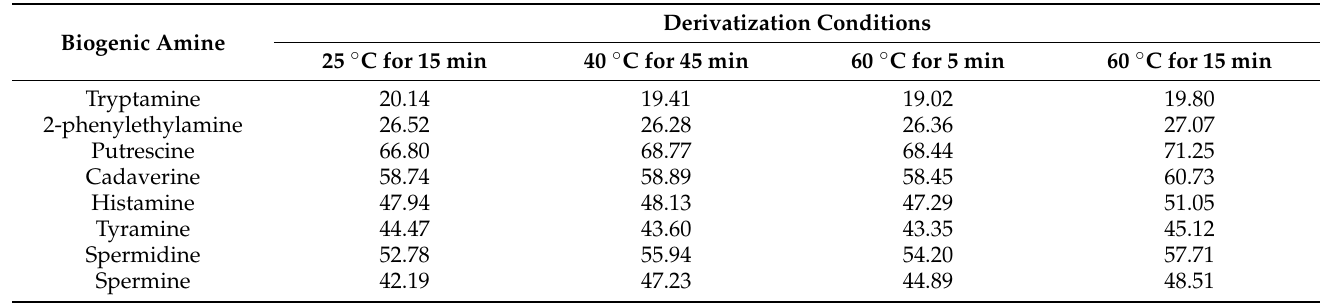
Table 2. Comparison of biogenic amine peak areas of standard solution (25 µ g/mL) derivatized by dansyl chloride in four different temperature-time conditions.